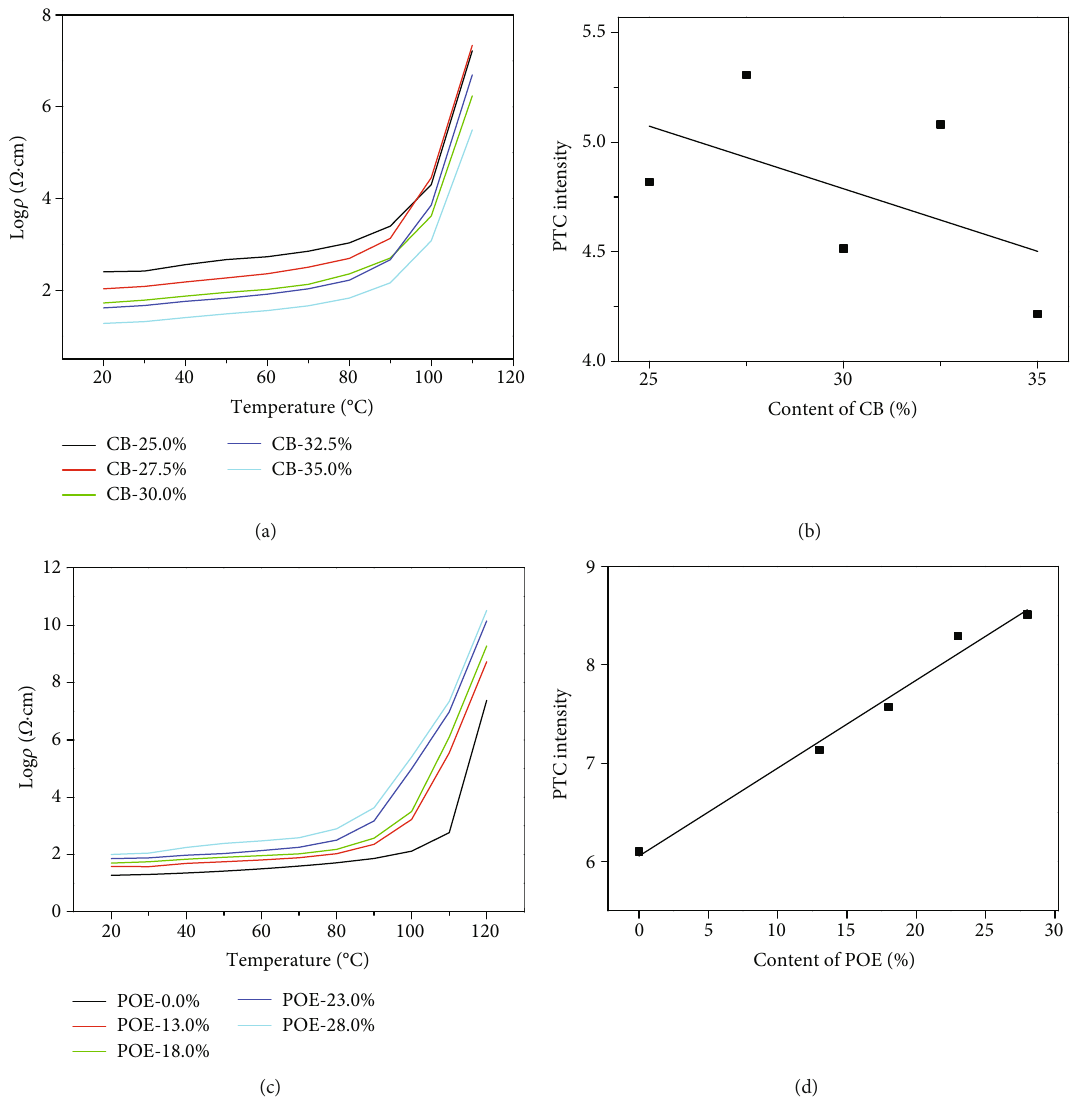
Figure 3: (a) The PTC behaviors of HDPE/POE/CB with various CB content (POE content is 18%). (b) Plot of PTC intensity of HDPE/POE/CB with various CB content (POE content is 18%). (c) The PTC behaviors of HDPE/POE/CB with various POE content (CB content is 18%). (d) Plot of PTC intensity of HDPE/POE/CB with various POE content (CB content is 18%).